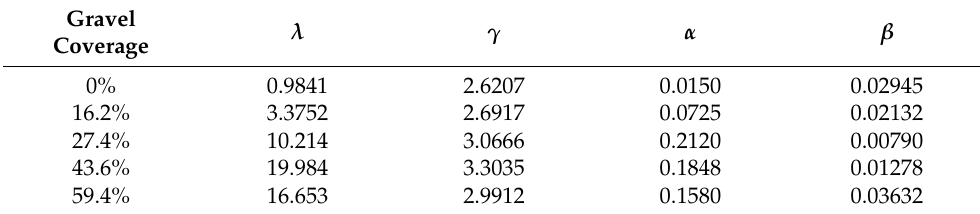
Table 3. Parameters of fit